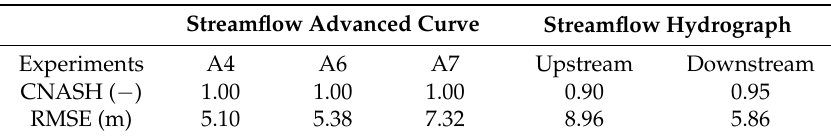
Table 6. Values of the performance criteria calculated during the validation step of the fitting process. CNASH is the Nash criterion. RMSE is the Root Mean Square Error between simulated and measured data. RMSE units are m for the advance curve and mm for the